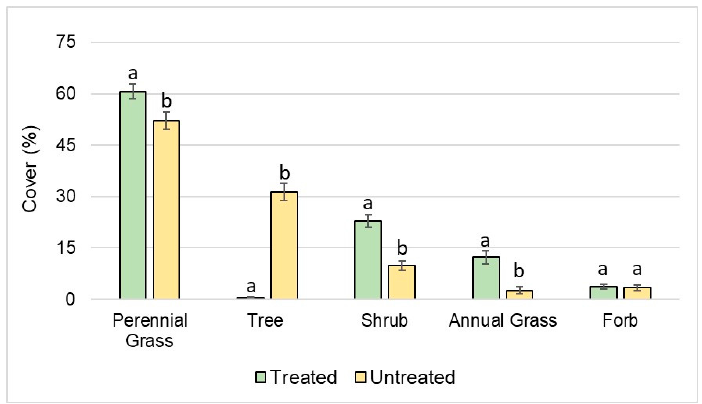
Figure 3. Mean (± SE) values of relative canopy cover by functional vegetation group across the treated and untreated watersheds. Means with the same letters are not significantly different ( p > 0.05).